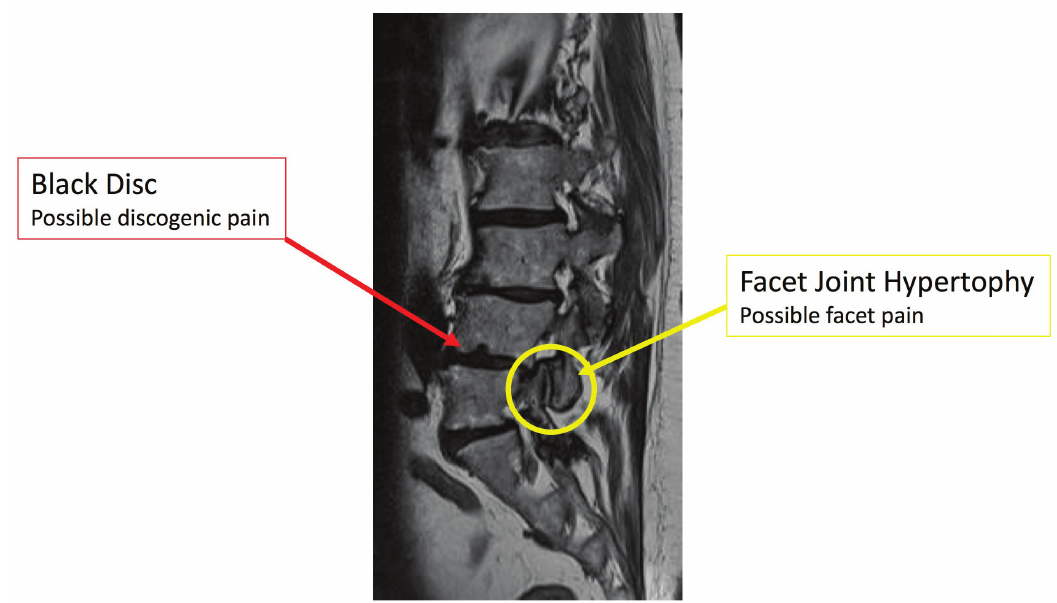
Figure 1. MRI sagittal image showing an abnormal alignment of lumbar vertebrae; black discs (red arrow) are pathogenetic for discogenic pain; facet joint hypertrophy (yellow arrow) is pathogenetic for facet joint pain.